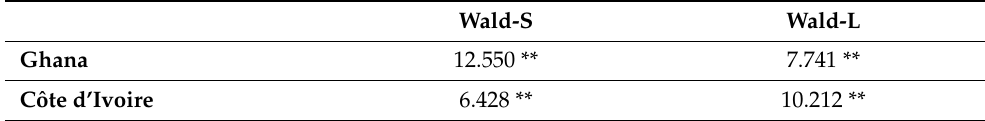
Table 5. Wald Tests Associated with Nonlinear ARDL